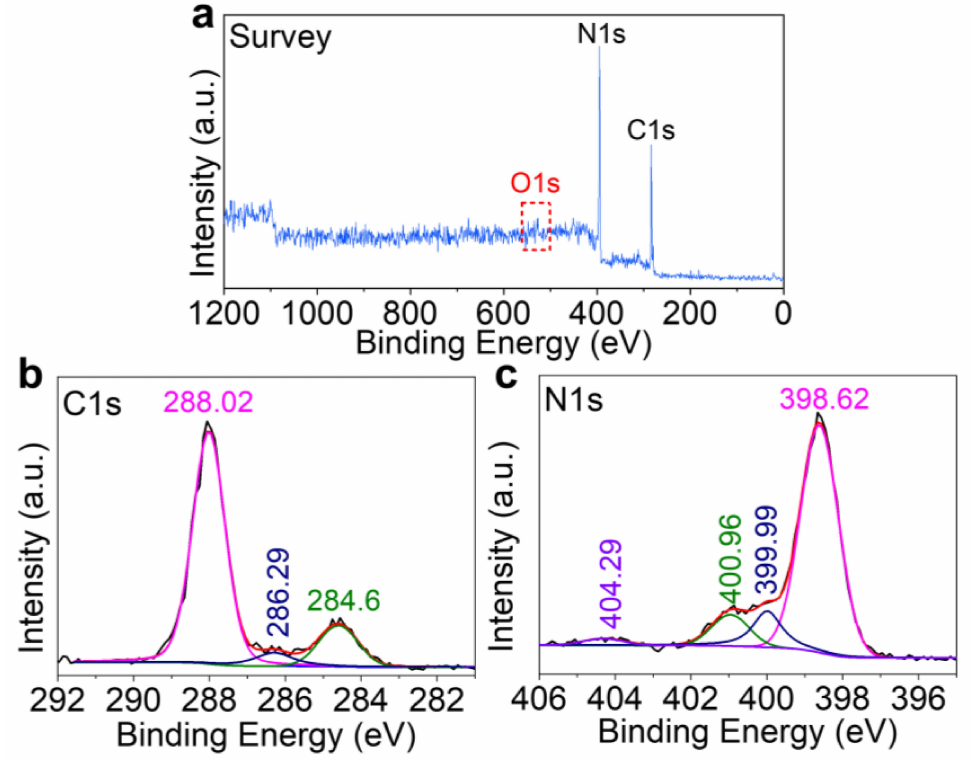
Figure 4. XPS spectra of CN/FTO-520 film: ( a ) survey scan, ( b ) C1s and ( c ) N1s. To know the detailed chemical structures of the g-C 3 N 4 films, the Attenuated total reflectance Fourier transform infrared spectroscopy (ATR-FTIR) spectra of melamine pre- cursor, g-C 3 N 4 powder, FTO substrate and CN/FTO films obtained at different heating temperature were measured in the wavenumber range of 650 to 4000 cm − 1 as shown in Figure 5. IR spectrum of the bare FTO substrate did not show any peak. Thus, all the peaks of CN/FTO films should come from the g-C 3 N 4 thin film rather than the FTO substrate. melamine (810 cm − 1 ), CN-520 powder (804 cm − 1 ) and CN/FTO films (822 cm − 1 )